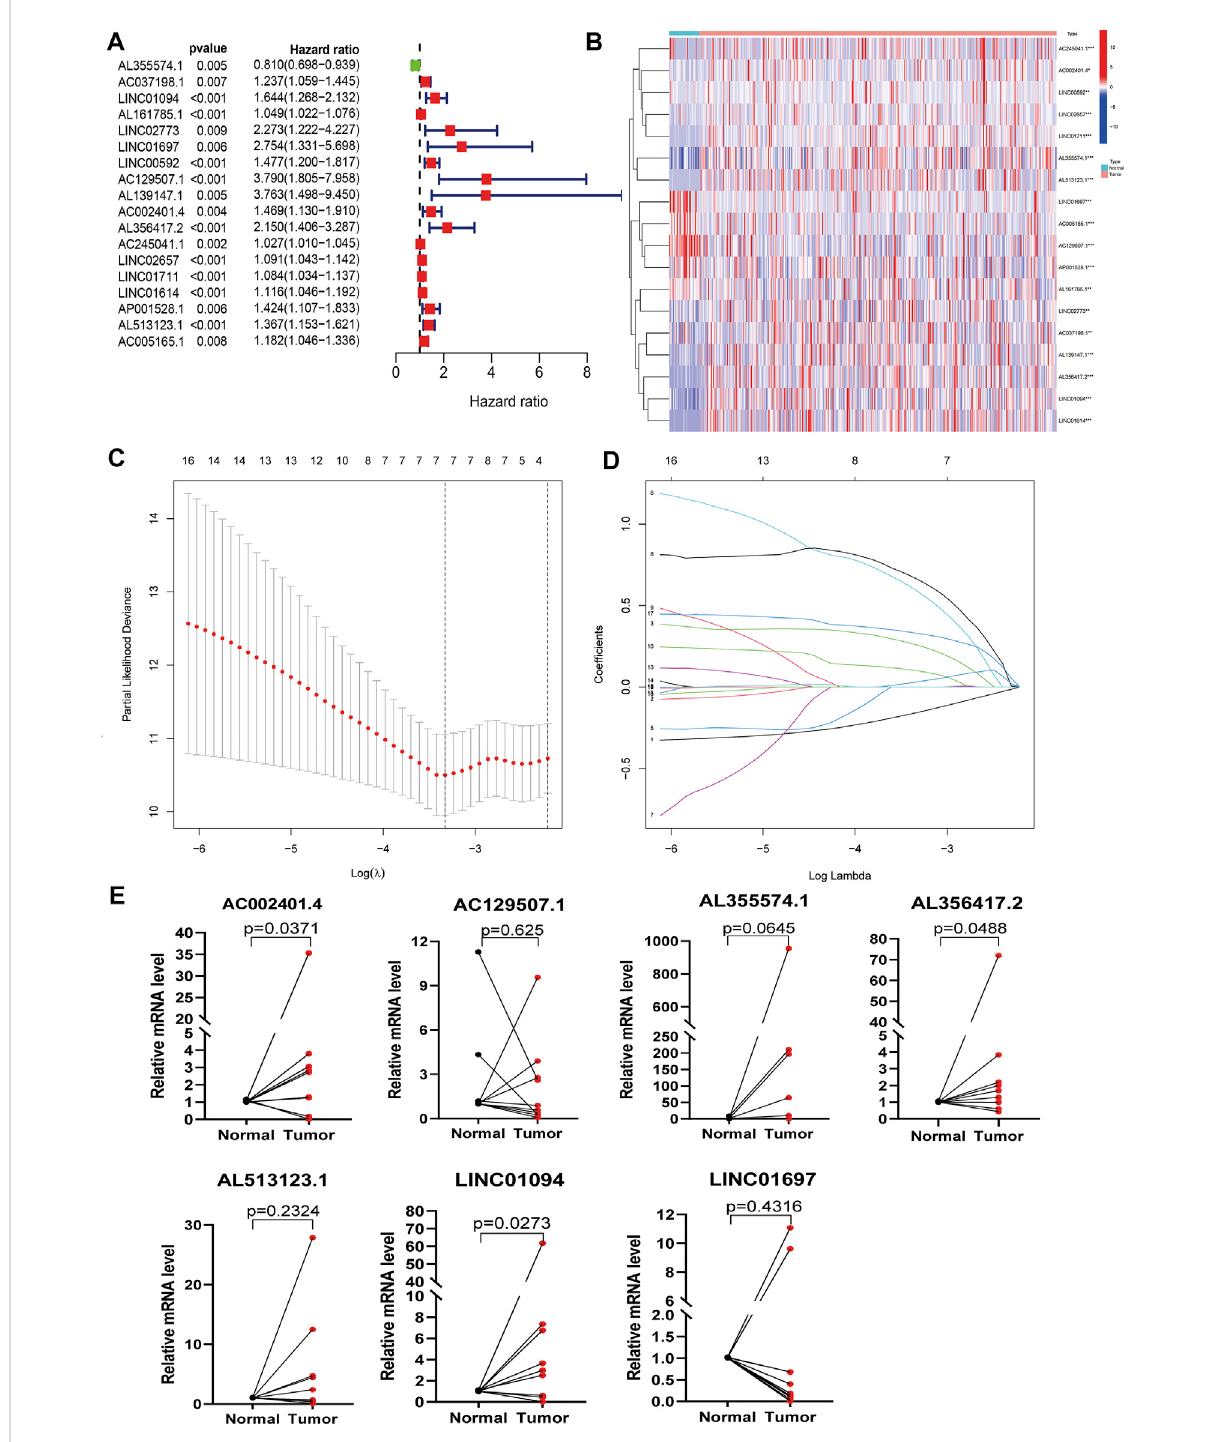
FIGURE 2 Identi fi cationofPLT-relatedlncRNAsinpatientswithGC. (A) UnivariateCoxregressionanalysis wasusedtoextracttheprognosticlncRNAs. (B) Heatmaps of 18 prognostic lncRNAs expression of patients (*** p < 0.001 * * p < 0.01 * p < 0.05). (C) The LASSO coef fi cient pro fi le of 18 PLT-related lncRNAs. (D) TheLASSOcoef fi cientdistributionsofOS-relatedlncRNAsandverticaldashedlineswereplottedwiththevaluesselectedfor10xcross- validation. (E) The results of qRT-PCR of PLT-related lncRNAs of 10 pairs GC